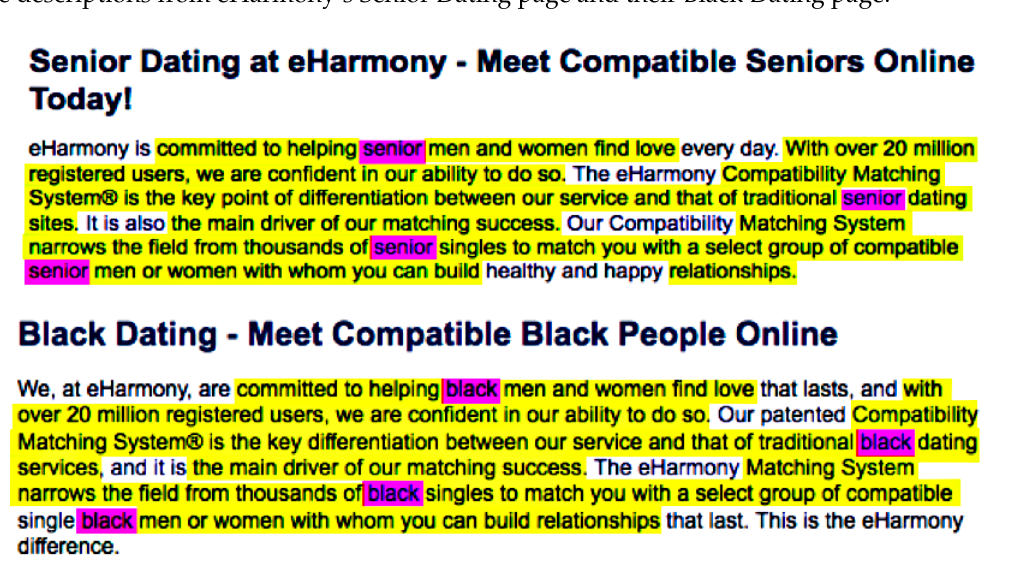
Figure 2. Taken from eHarmony’s Senior Dating and Black Dating sites (highlights added) [35,36].